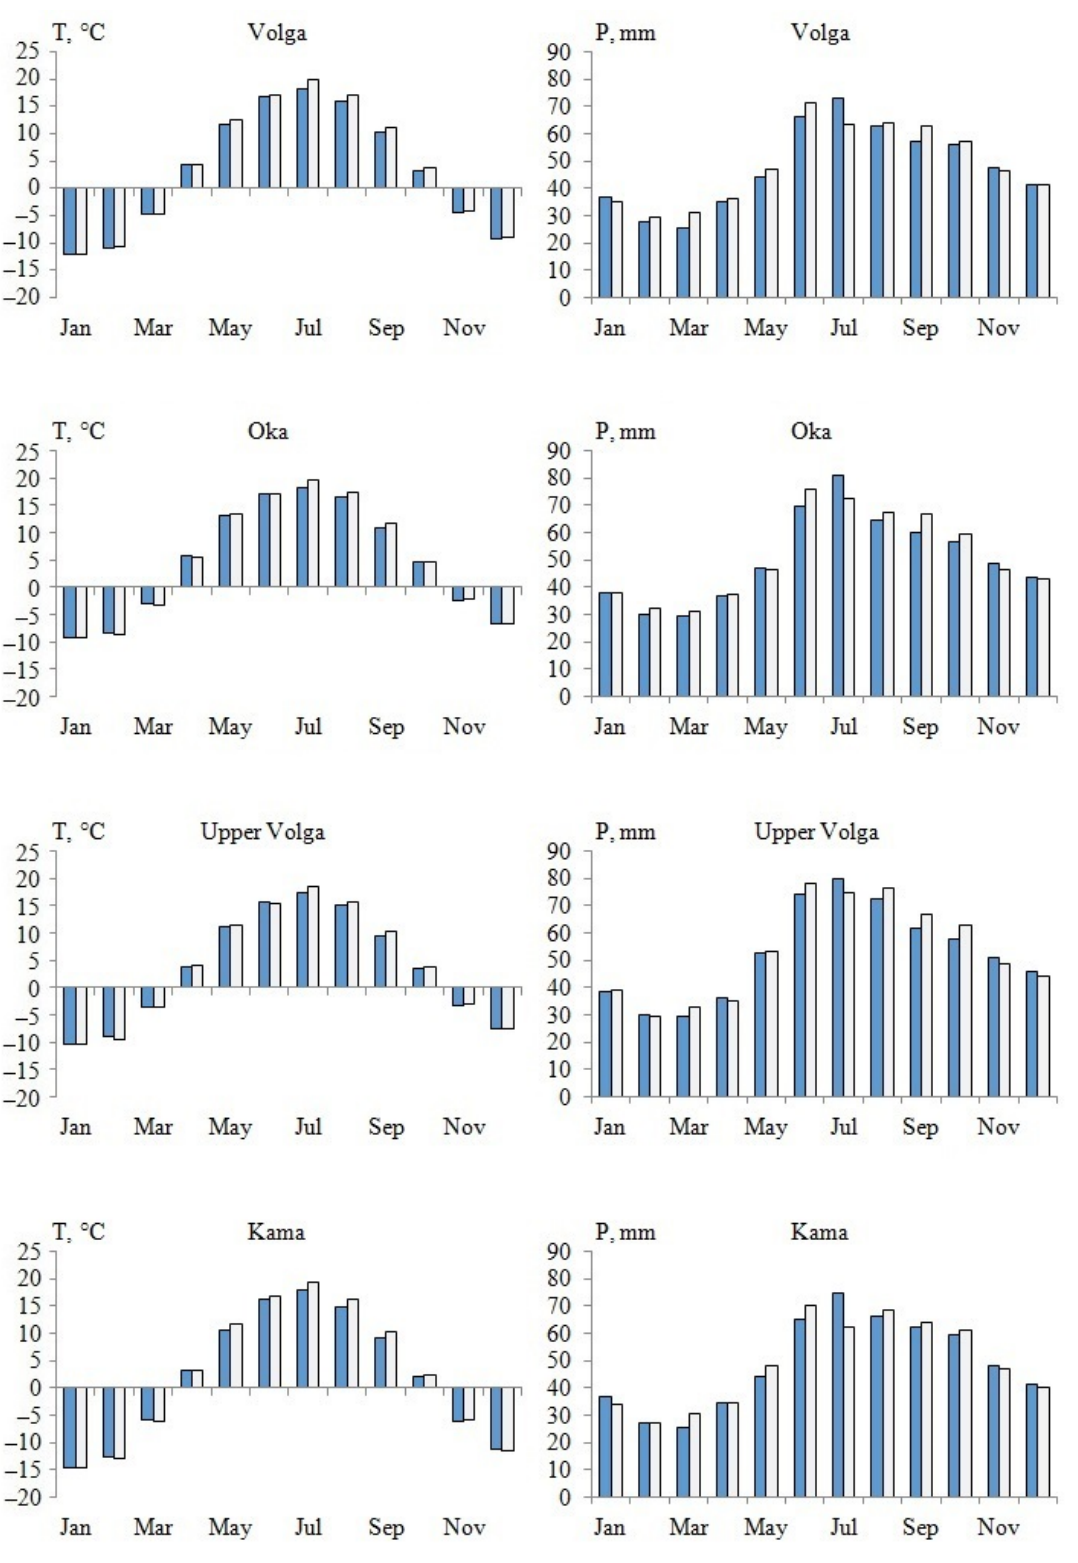
Figure 3. Averaged basin mean monthly air temperature and precipitation calculated from observational data and GCMs ensemble for the Volga, Oka, Upper Volga and Kama basins for the period 1970–1999.